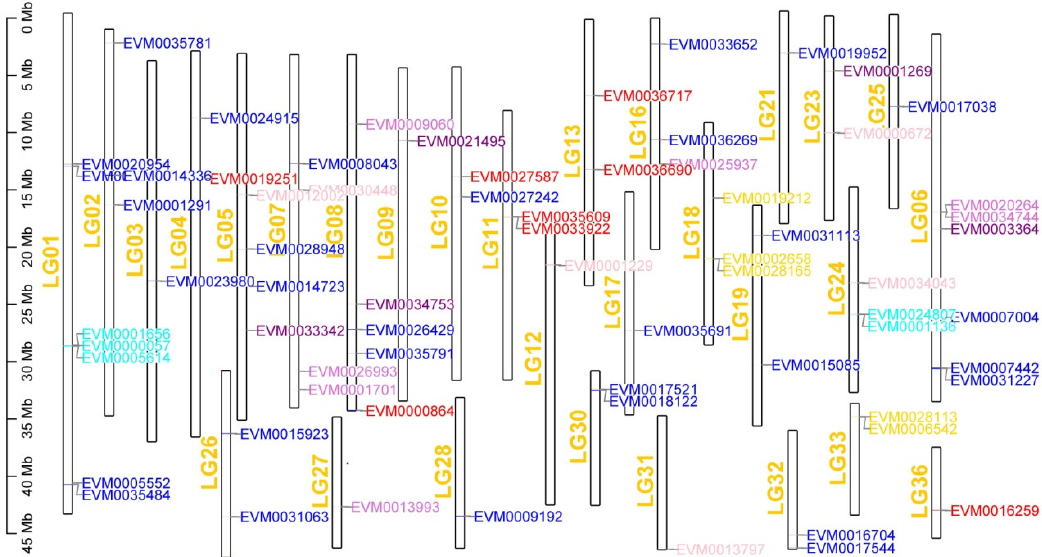
Figure 5. Physical distribution of GnRH signaling pathway-expanded genes in male O. bidens ’ genome. The gene-marked colors indicate gene-expanded number (≥3, see Tables S5 and S6).